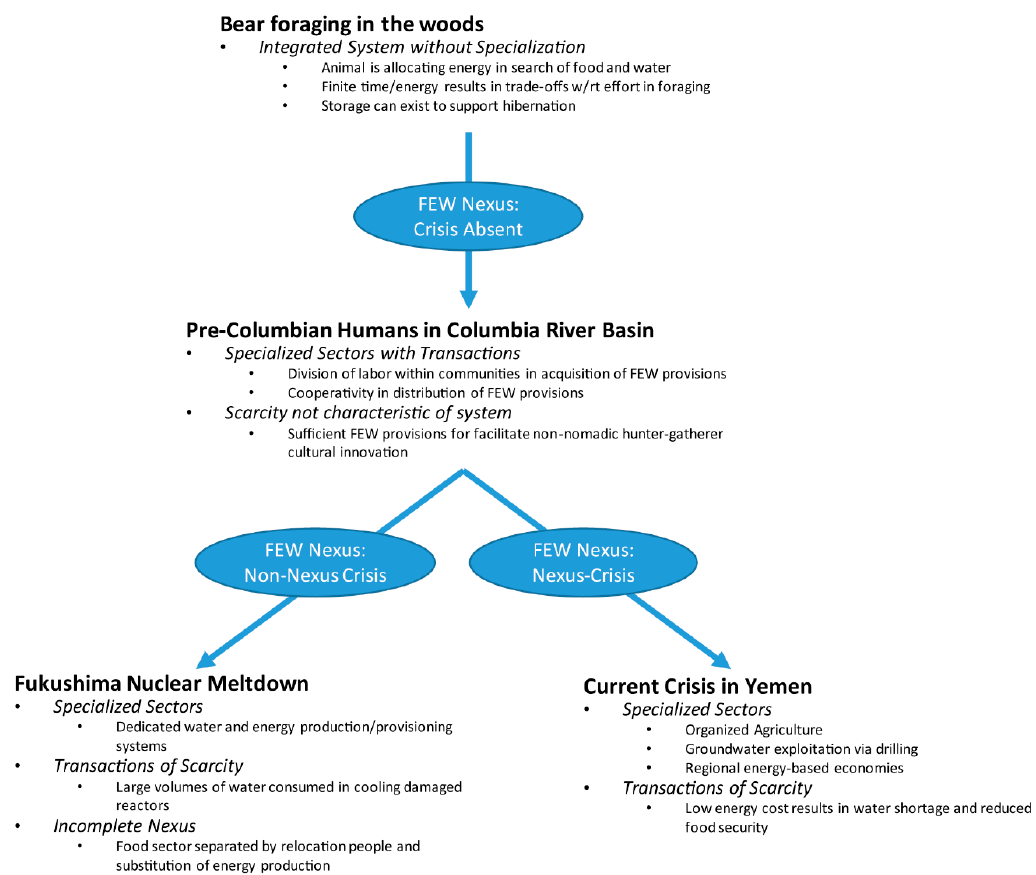
Figure 3. Conceptual relationships between systems discriminate FEW / non-FEW and problem / non- problem cases. Not all situations related to food, energy, and water are a FEW nexus or in need of a FEW nexus solution; this relational map illustrates how the criteria within the definition of a FEW nexus can discriminate cases. The arrows in this figure are intended to indicate conceptual transition, not necessarily temporal or developmental flow.